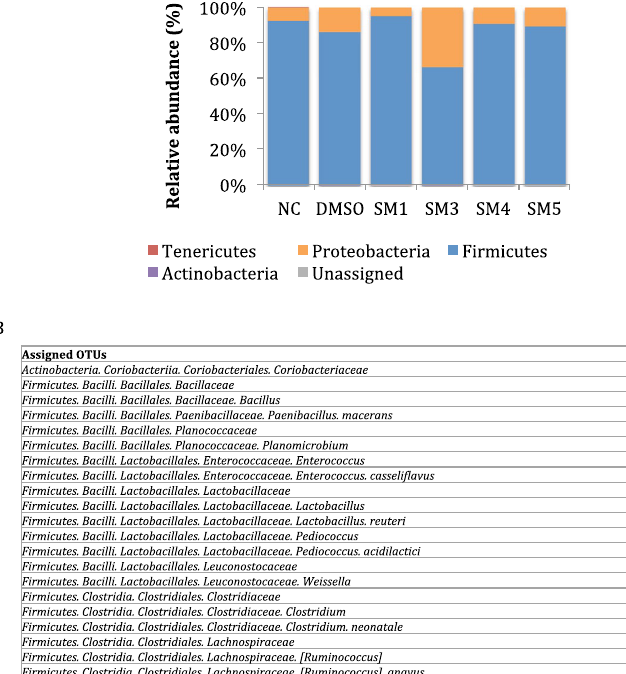
Figure 7. Impact of the small molecule (SM) treatments on microbiota diversity and relative abundance in chicken ceca. ( A ) Relative abundance at the phylum level. ( B ) Taxonomic diversity and significant differences between treatments in the cecal microbiota. In green: operational taxonomic units (OTUs) detected in the chicken ceca; in red: OTUs not detected in chicken ceca; A and B indicate whether the OTUs were significantly lower or higher, in abundance, respectively, compared to the 1% dimethyl sulfoxide (DMSO) group (P < 0.01); N and NC: not infected, not treated; D: DMSO-treated; 1, 3, 4, 5: treated with SM1, SM3, SM4, or SM5,